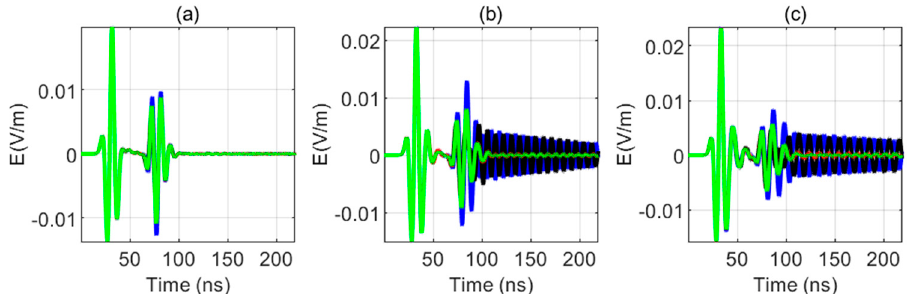
Figure 14. Received signals of the four receiving antennas for sondes with di ff erent dielectric constants (blue: the east antenna; black: the west antenna; red: the south antenna, green: the north antenna); ( a ) the sonde dielectric constant is 13, ( b ) the sonde dielectric constant is 43, and ( c ) the sonde dielectric constant is 73.